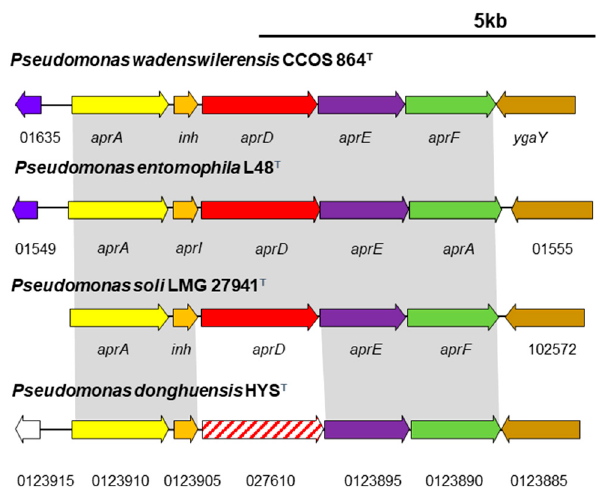
Figure 5. Type I secretion cluster (T1SS) for the secretion of alkaline protease. The same gene arrangement of the genomes is shaded in grey. Orthologous genes are marked in the same color. Dashed color indicates weak levels of sequence identity.